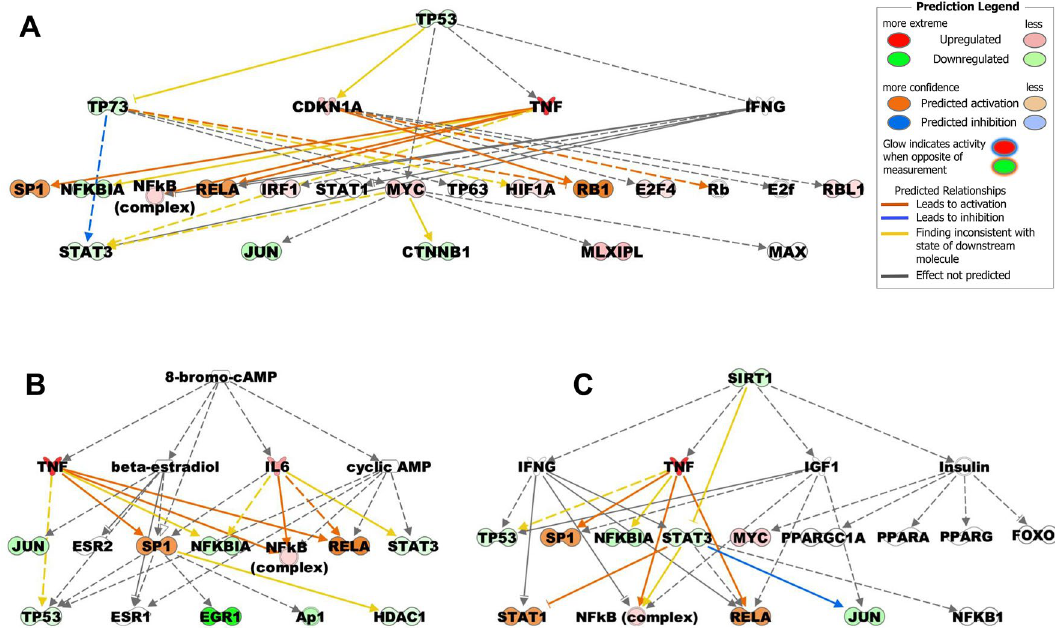
in gene expression between SFPQ over-expressed and control CFBE41o − cells. The color of the bars indicates the value of the differential expressions, as indicated in the legends. Solid arrows represent the genes that interact directly, dotted arrows represent indirect interactions between